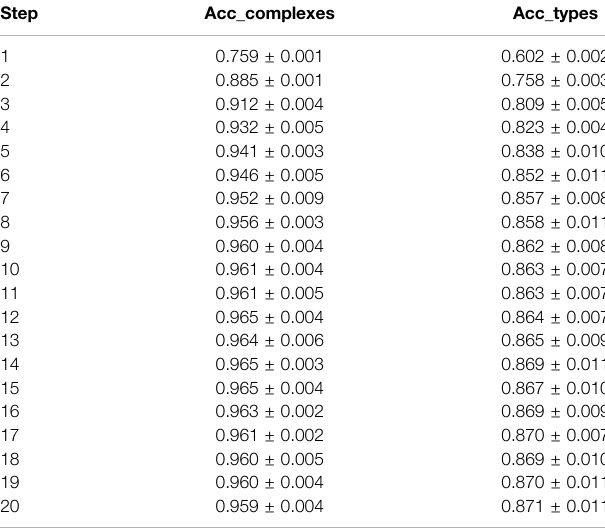
TABLE 8 | Accuracy for the classi fi cation of complexes and types per step of sequential feature selection on spectral features.